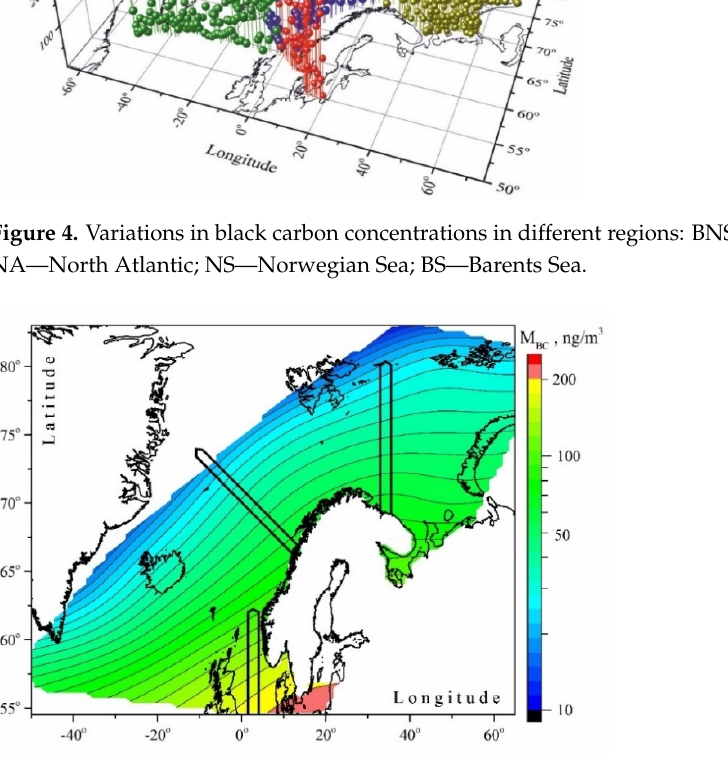
Figure 5. Average spatial distribution of black carbon concentrations; arrows indicate the directions of decreasing M BC concentrations in the sectors of the North, Norwegian and Barents Seas, which are analyzed in Section 3.2.